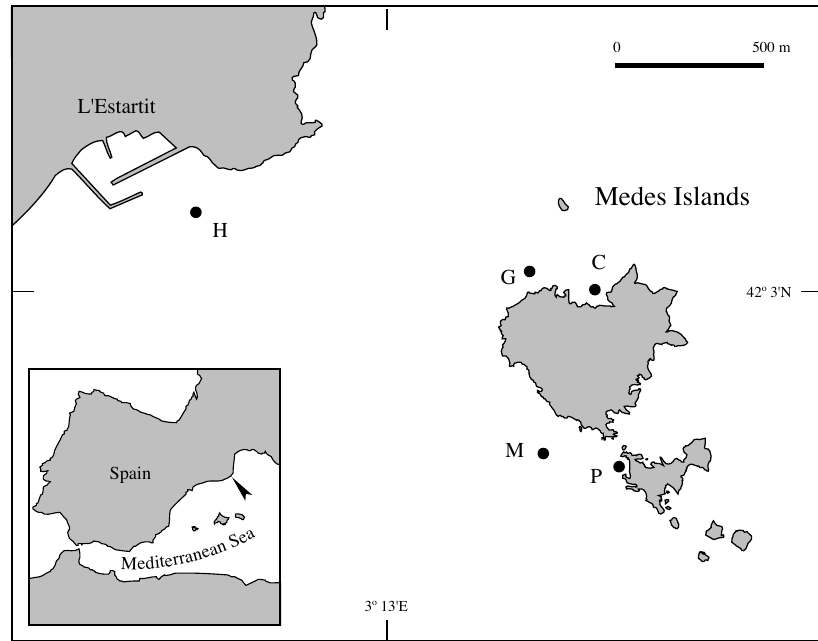
- Site P: el Portitxol, detritic bottom between 3 - Site C: la Cuetera, rocky bottom with